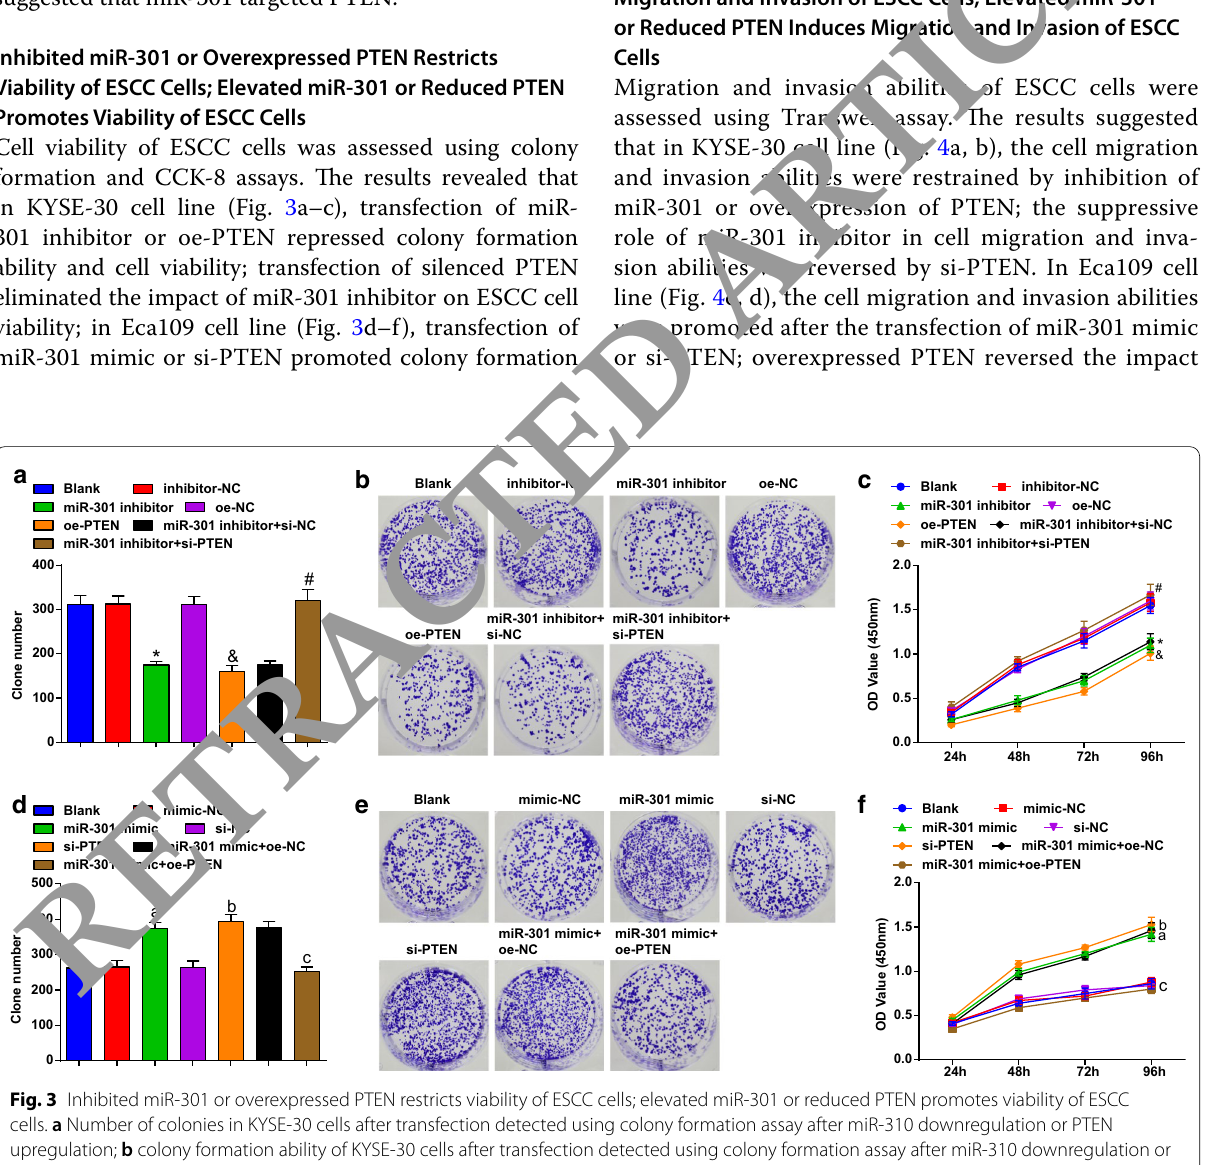
si-NC group; a P < 0.05 versus + oe-NC group, N 3. Data were expressed as + =